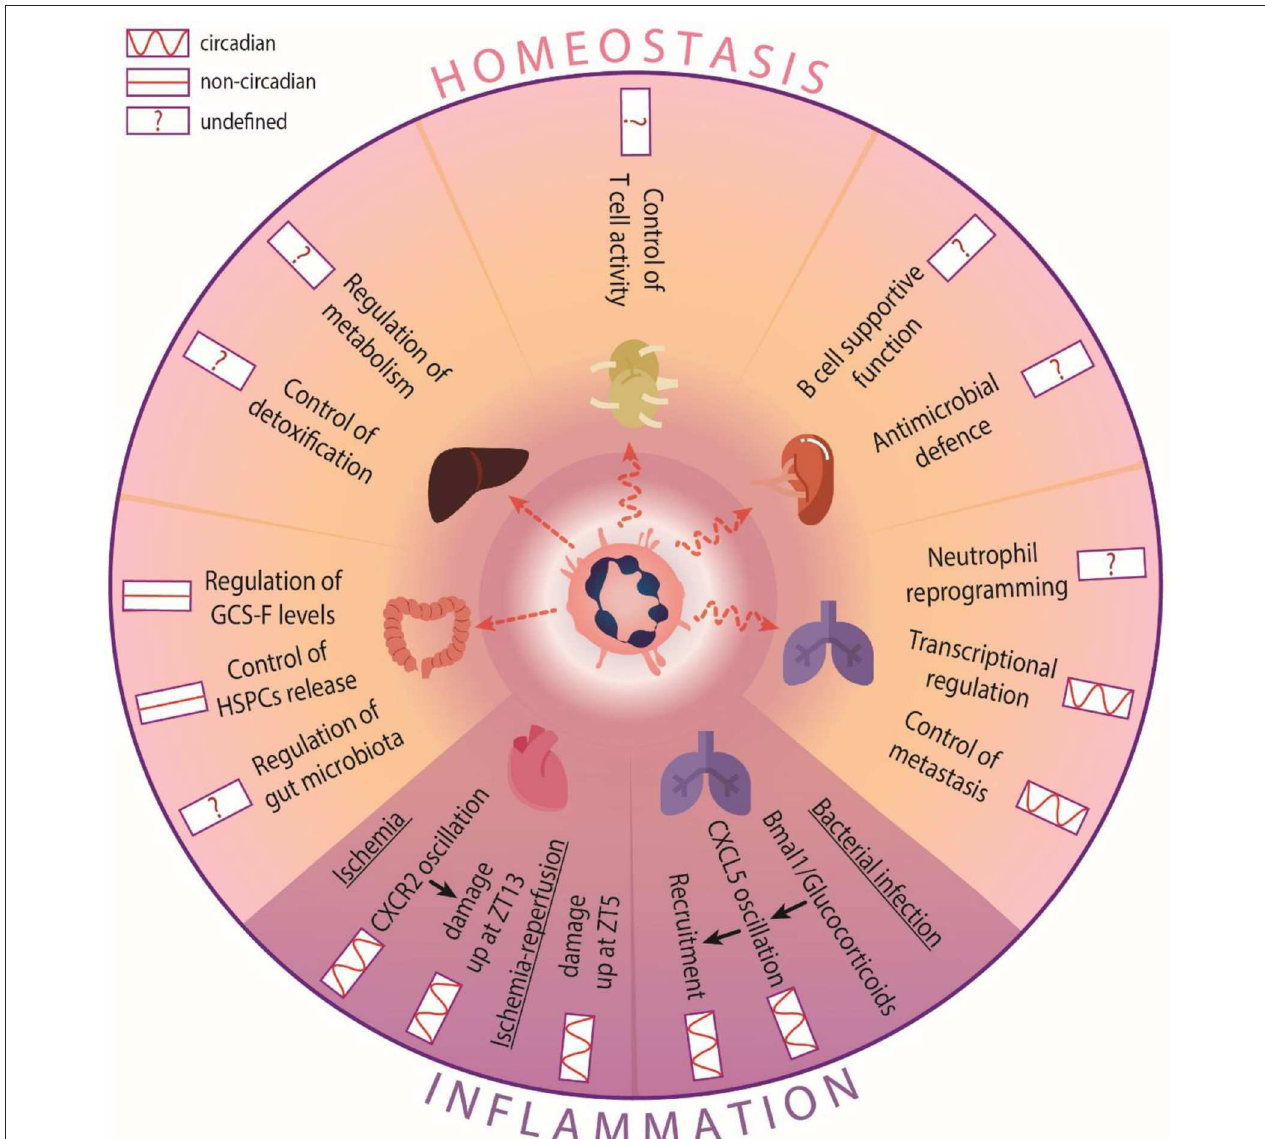
FIGURE 2 | Circadian functions of neutrophils in tissues. In homeostasis, neutrophil infiltration into most tissues is circadian, but not in the intestine or the liver. Neutrophils perform different functions in a circadian-independent manner: In the intestine, they control G-CSF production to mobilize HSC. In other tissues they regulate circadian processes, such as transcriptional programs and tumor invasion in the lung. The circadian influence in other tissues is not well-defined. For example, metabolism or detoxification control in the liver, gut microbiota regulation in the intestine, or their own re-education and immune defense in the spleen or lymph nodes, respectively. In inflammatory scenarios, neutrophil recruitment oscillates and influences disease outcome. During bacterial infection in the lung, bronchiolar cells modulate CXCL5 expression to control the oscillatory recruitment of neutrophils. In models of cardiac ischemia, increased infiltration into the heart accounts for exacerbated cardiac damage at different times depending on the type of injury